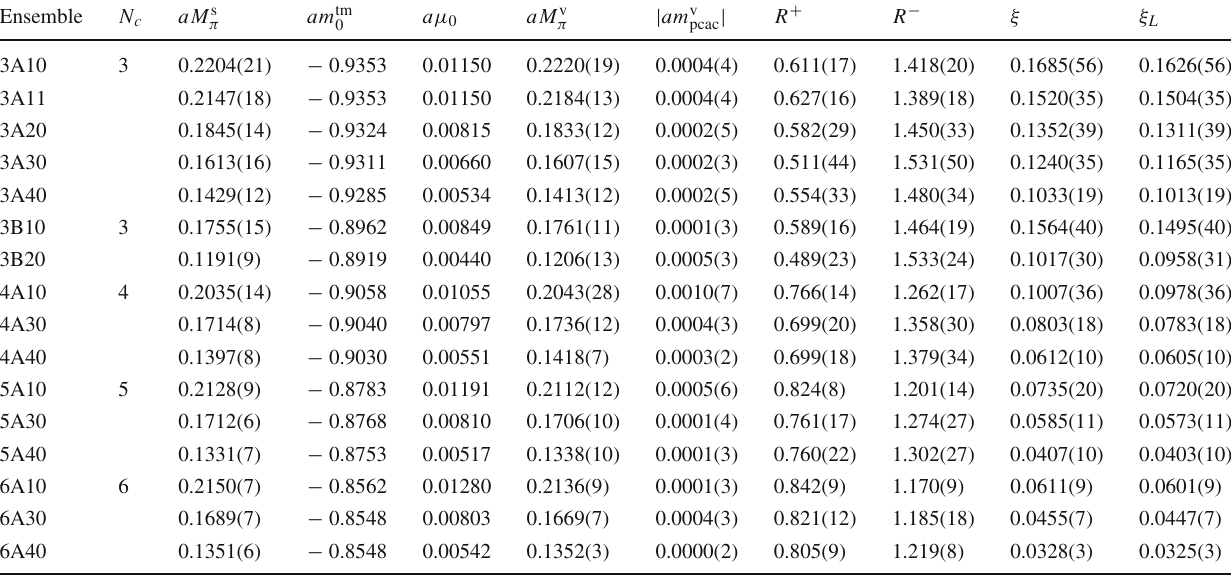
Table 4 Summary of results for our ensembles with Iwasaki gauge action and O ( a ) -improved Wilson fermions with c sw = 0 in the valence sector throughout. The value of the lattice spacing is a (cid:6) 0 . 075 fm for the “A” ensembles (see Ref. [27]), whereas it is a (cid:6) 0 . 065 fm for “B” ensembles. We provide the pion mass in the valence sector, aM v π , and